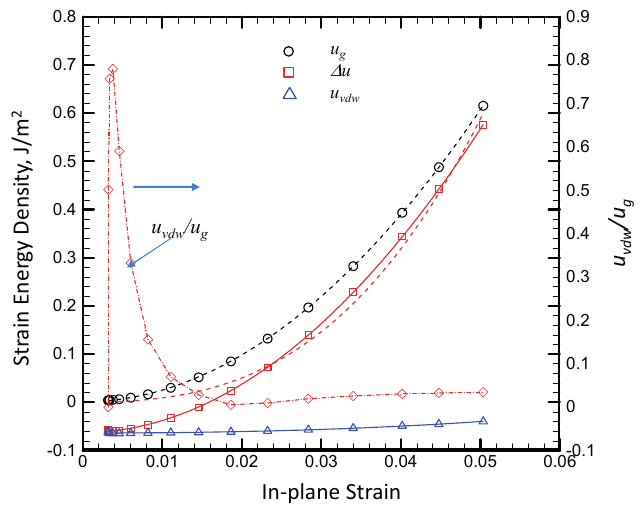
(the strain energy of graphene) and g / u vdw g